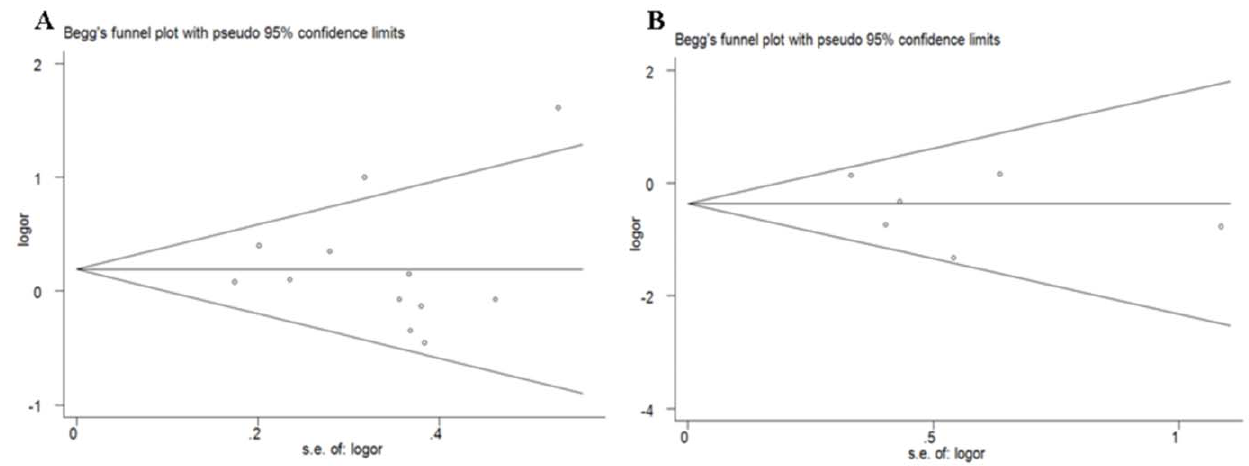
Figure 5. Funnel plot analysis to detect publication bias. Each point represents a separate study for the indicated association. A Funnel plot for contrast TT vs. CC of C677T polymorphism in overall analysis; B Funnel plot for allele contrast CC vs. AA of A1298C polymorphism in overall analysis.